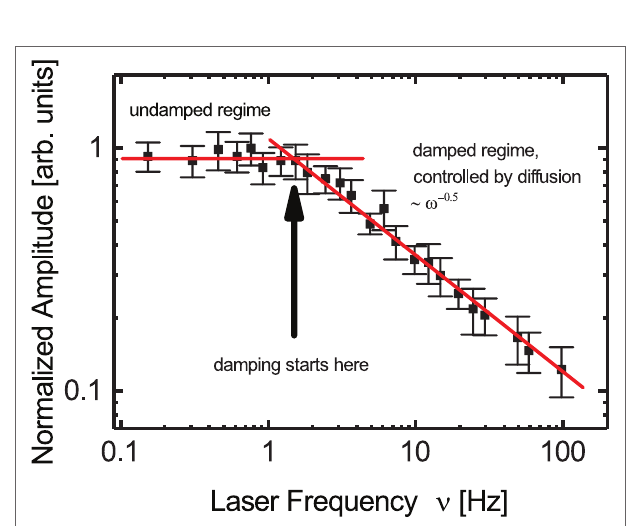
FigURe 7 | Normalized temperature amplitude of the water surface for different heating frequencies for a measurement with a wind speed of 3.6 m/s in the Heidelberg wind-wave facility Aeolotron. It can clearly be seen that from a certain heating frequency onward, the temperature amplitudes start to